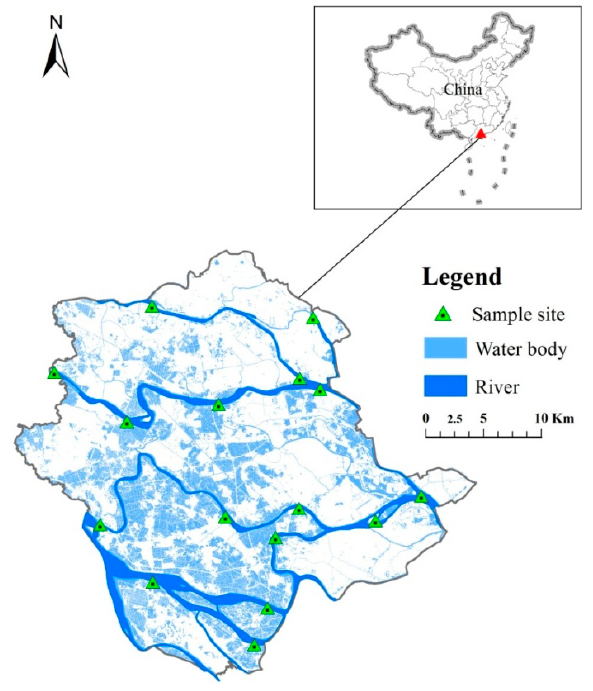
Figure 1. The spatial distribution of the 16 sample sites in study area of Shunde district.